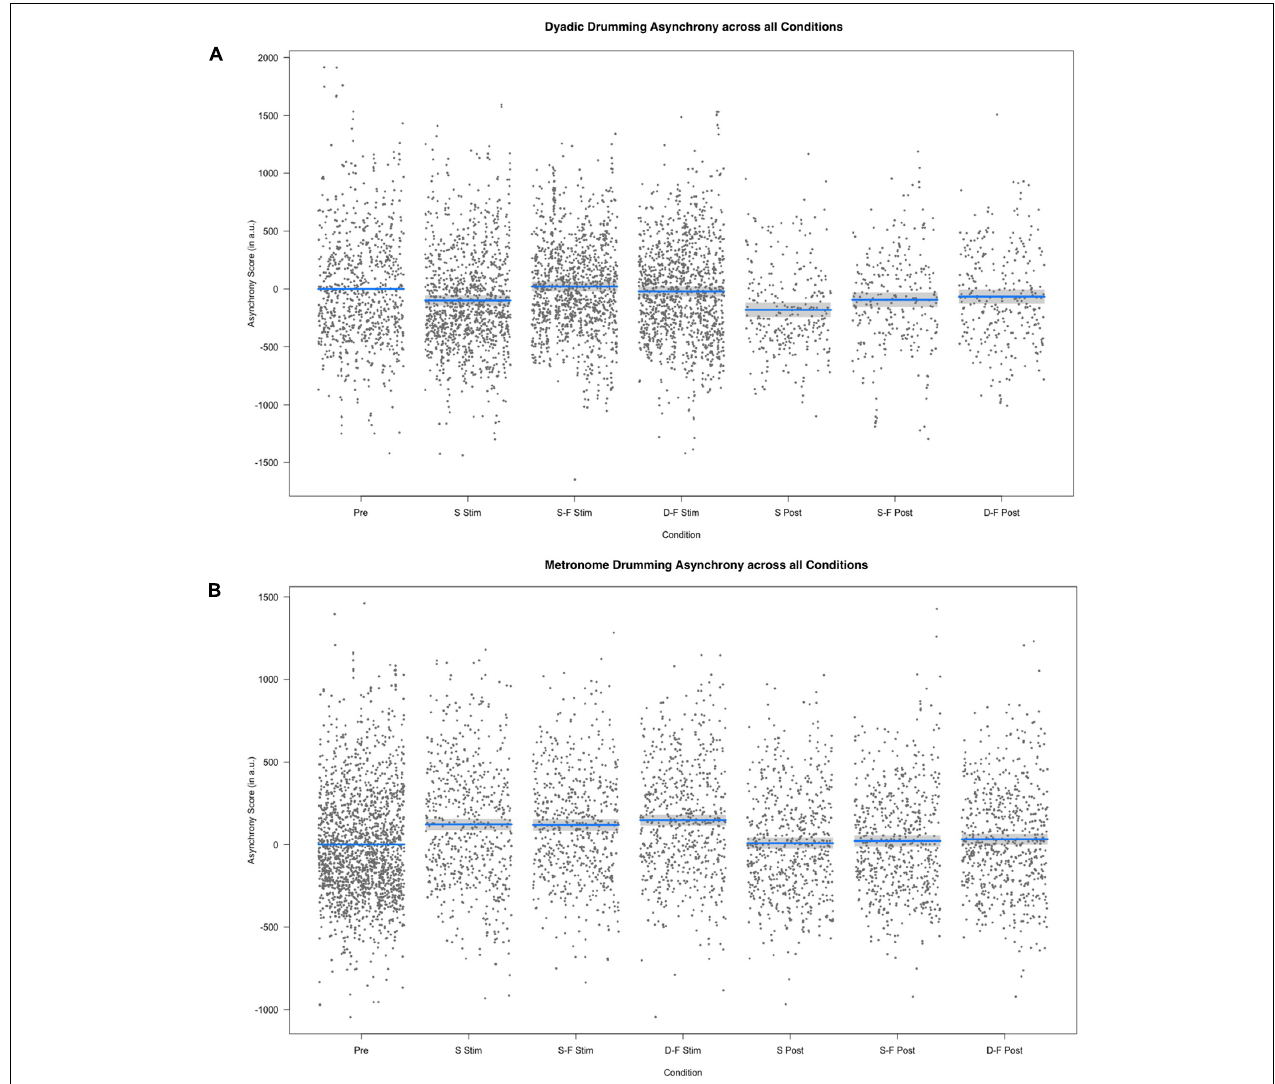
FIGURE 3 | Results of the fixed effect of the linear mixed model analysis for the effect of condition on asynchrony scores. (A) Partial residuals as estimated by the mixed model for dyadic drumming. (B) Partial residuals as estimated by the mixed model for metronome drumming. Stimulation conditions: Pre, pre; S Stim, sham stimulation; S-F Stim, same-phase-same-frequency stimulation; D-F Stim, different-phase-different-frequency stimulation; S Post, sham post; S-F Post, same-phase-same-frequency post; D-F Post, different-phase-different-frequency post. Blue lines indicate model prediction values. 95% confidence intervals are displayed as gray